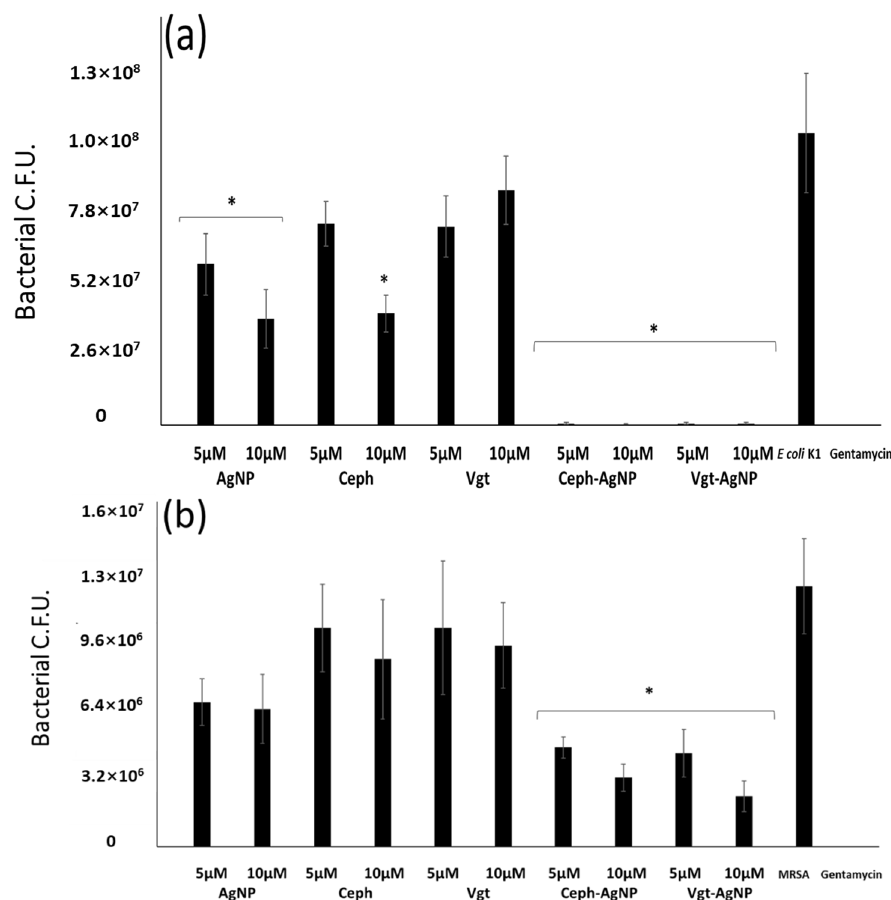
Figure 3. E. coli K1 ( a ); MRSA ( b ); colonies were determined following incubation with drugs alone, Ag alone, AgNPs conjugated with drugs. Briefly, 1 × 10 6 E. coli K1 , MRSA colonies were incubated with drugs and controls at 37 °C for 24 h. Next, colonies were accounted. Both drug-conjugated AgNPs exhibited significant bactericidal effects ( p < 0.05 using t -test, two-tailed distribution, as indicated by asterisk). The results are the mean ± standard error of three independent experiments performed in duplicate.